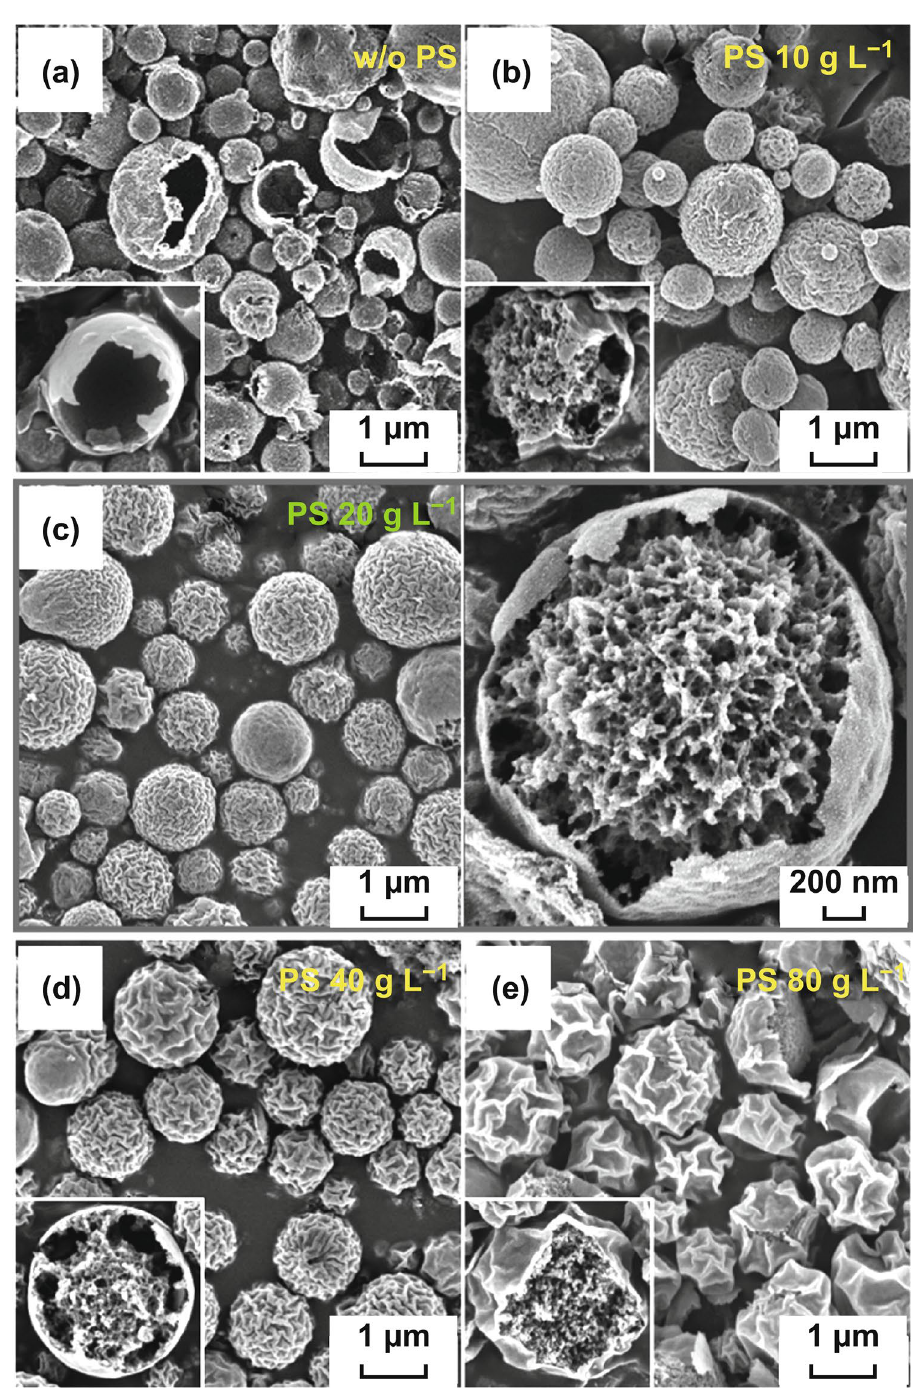
Fig. 2 Morphologies of the as‑prepared powders obtained from the solution containing Ni salt, PVP, and a without PS nanobeads, b with 10 g L −1 , c 20 g L −1 , d 40 g L −1 , and e 80 g L −1 PS